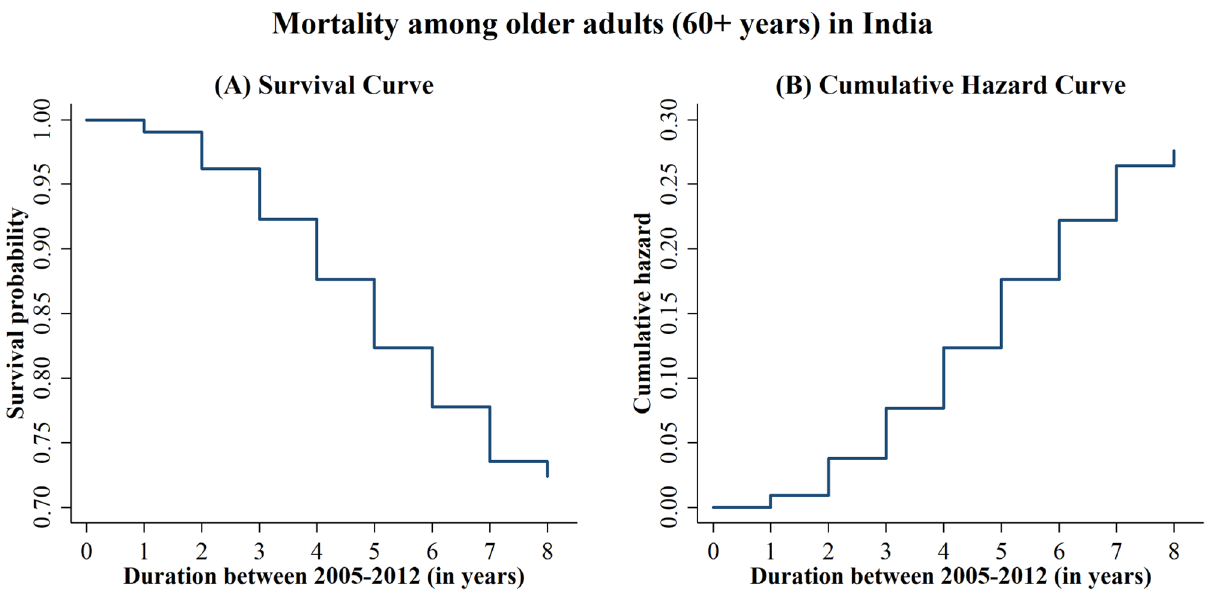
Figure 2. Survival plot and Cumulative Hazard plot of mortality among older adults in India between 2005 and